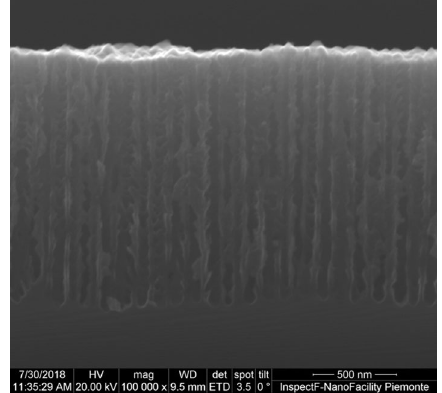
Figure 2. SEM image of the cross section of a typical sample, where the pore shape and size are visible.